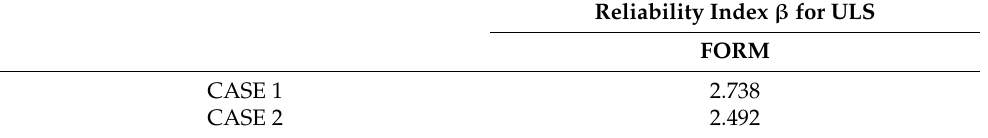
Table 6. Reliability index β for